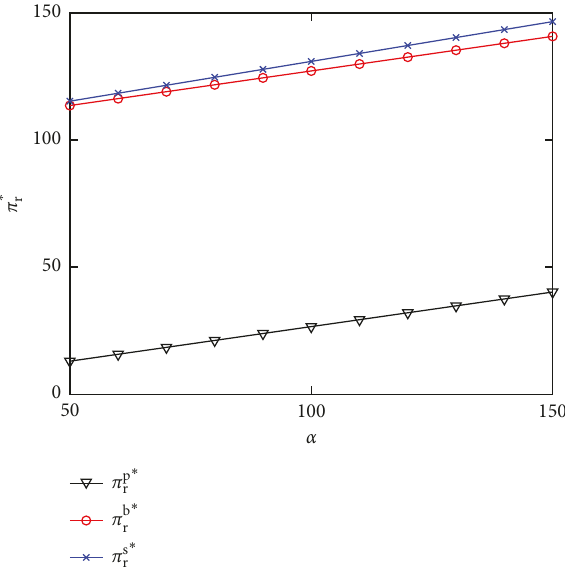
Figure 11: Impact of change in α on the rider’s optimal profit.